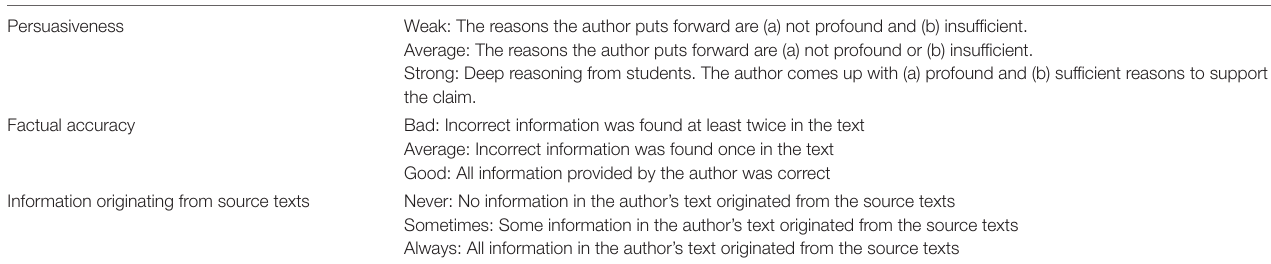
TABLE 7 | Coding of quality of content. Persuasiveness